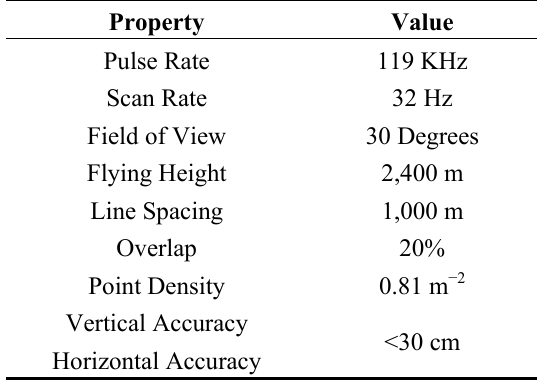
Table 1. Light Detection and Ranging (LiDAR) acquisition properties